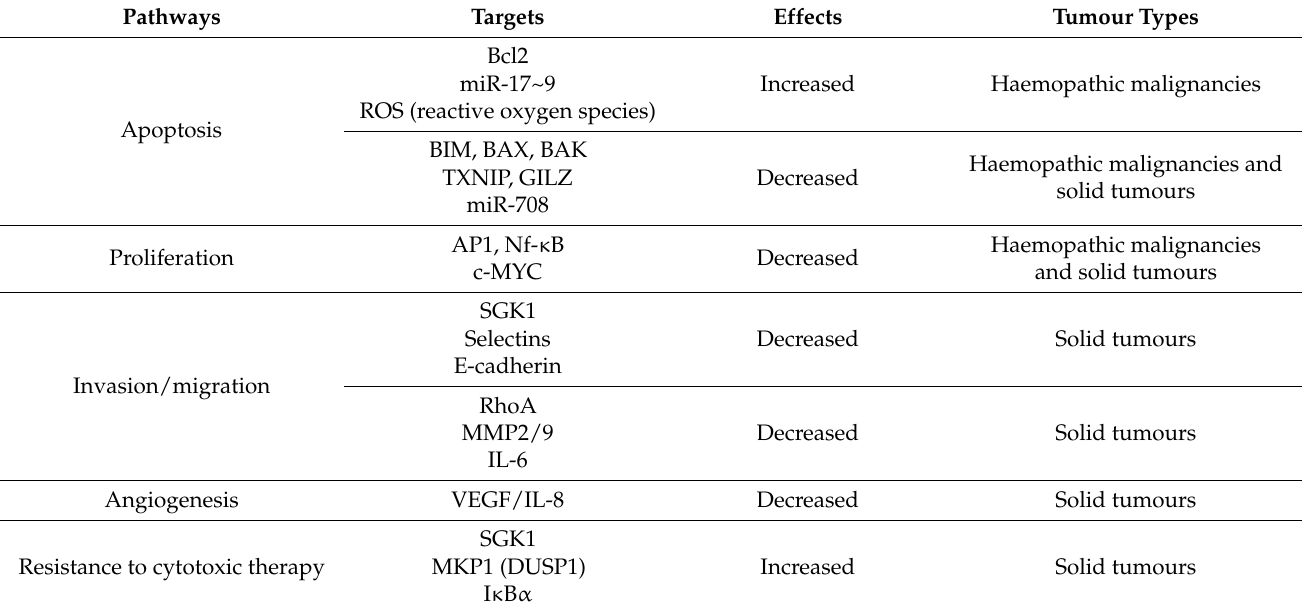
Table 1. Summarize of effects of glucocorticoids on tumour